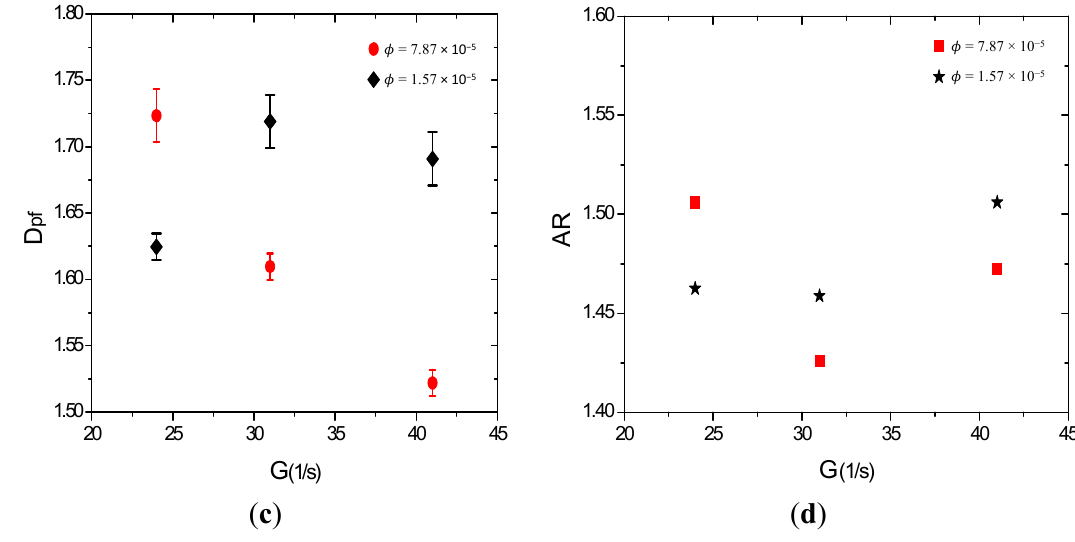
Figure 7. Morphological property parameters of the flocs at steady state with respect to different shear rates for the case in which the primary sediment concentration is 7.87 × 10 − 5 and the other case where the concentration is 1.57 × 10 − 5 without electrolyte added into the suspension, including 2-D fractal dimension ( a ); 1-D fractal dimension ( b ); perimeter-based fractal dimension ( c ); and aspect ratio ( d ). The error bars in ( a – c ) show standard deviations of D 2 , D 1 , and D pf values,